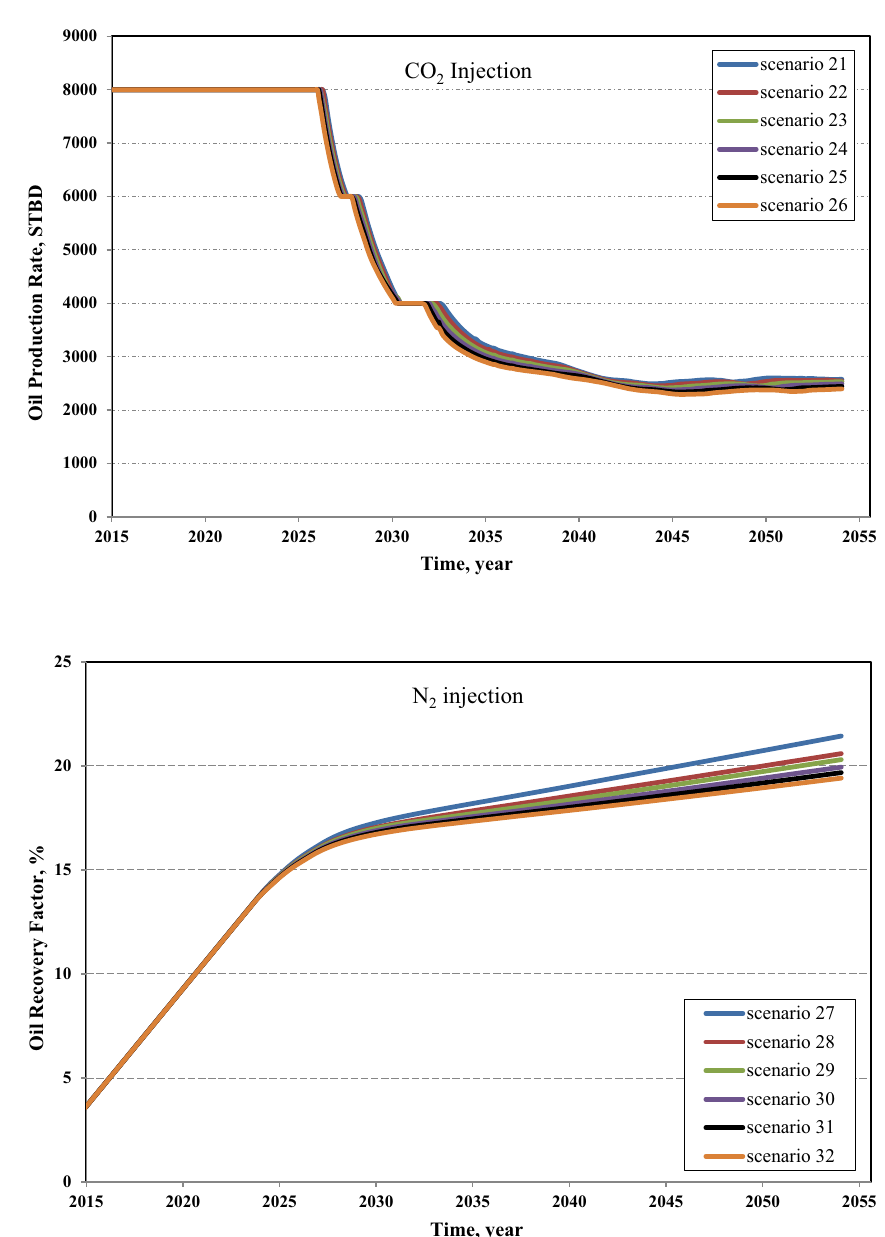
Fig. 11 Oil recovery factor for N 2 injection into different reservoir